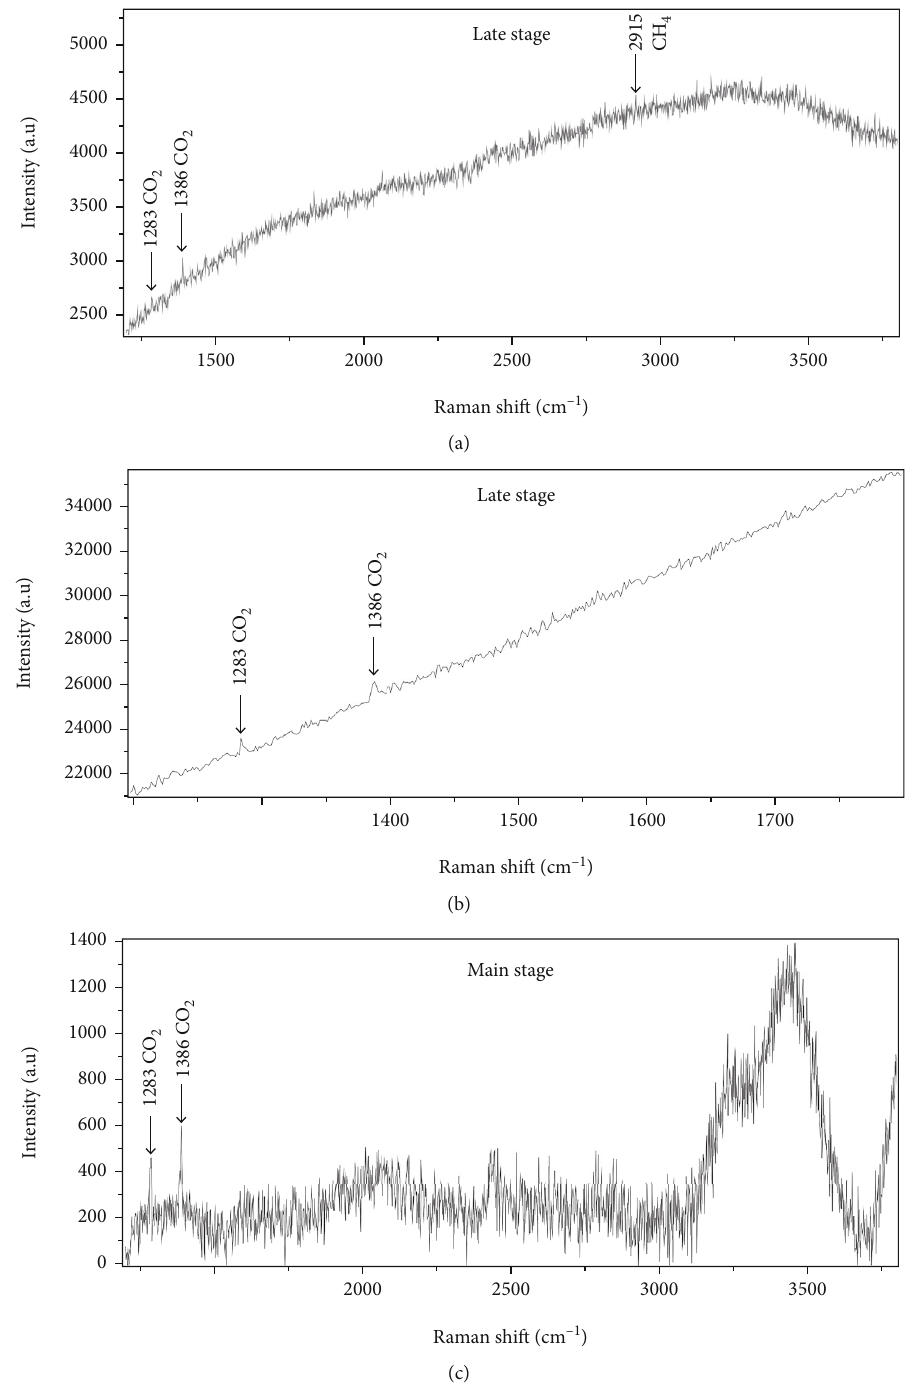
Figure 12: Laser Raman spectroscopy of di ff erent fl uid inclusions in the main stage (a) and late stage (b,